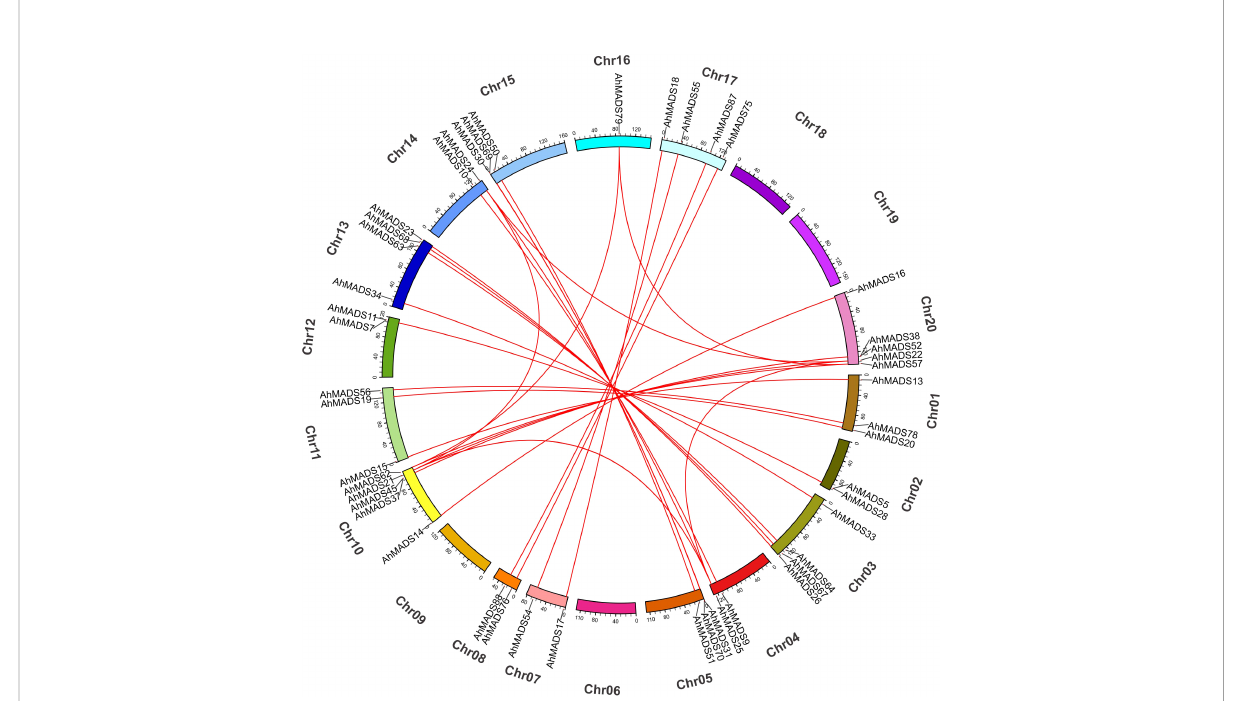
FIGURE 5 Chromosomal distributions and synteny relationships of MADS-box genes in peanut. Red lines indicate the duplicated AhMADS gene pairs in